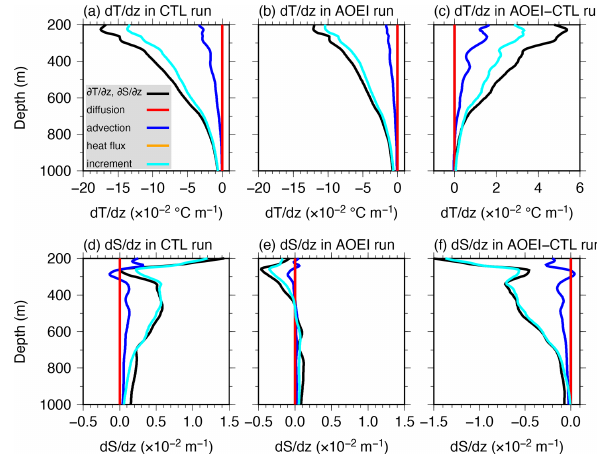
Figure 10. Panels (a) – (c) are the same as Fig. 9 but for each term of the temperature stratification tendency equation (Eq. 13): the tem- perature gradient tendency term (the LHS term; black), the temper- ature diffusion gradient term (the first term on the RHS; red), the temperature advection gradient term (the second term on the RHS; blue), the shortwave penetration gradient term (the third term on the RHS; orange), and the temperature increment gradient term (the last term on the RHS; cyan). Panels (d) – (f) are the same as panels (a) – (c) but for the salinity stratification tendency equation (Eq. 14). In panels (a) – (c) , we note that the shortwave penetration gradient term is almost zero and overlaps with the temperature diffusion gradient